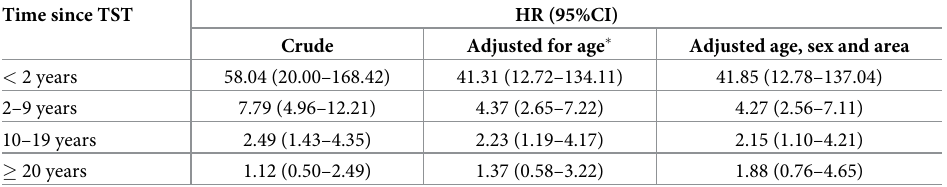
Table 3. Hazard ratios for tuberculosis by time since the tuberculin skin test for those with indurations > 17mm compared to those with indurations of < 5mm.